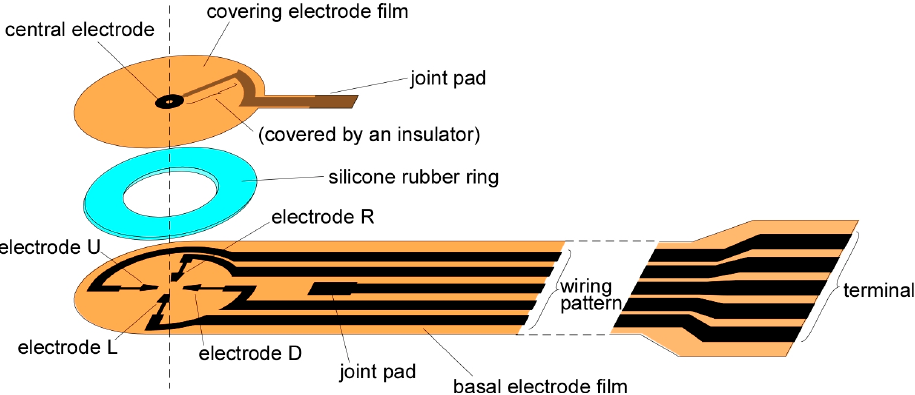
Figure 2. Schematic representation of the structure of the shear force sensor.